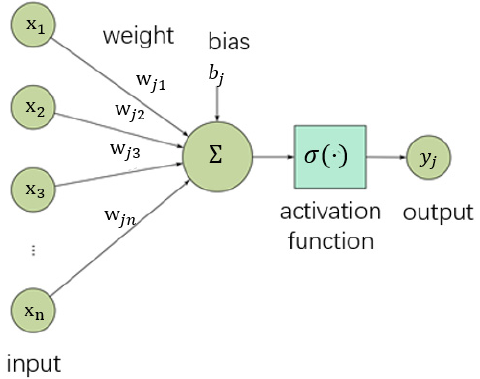
Figure 13. DNN neuron structure.